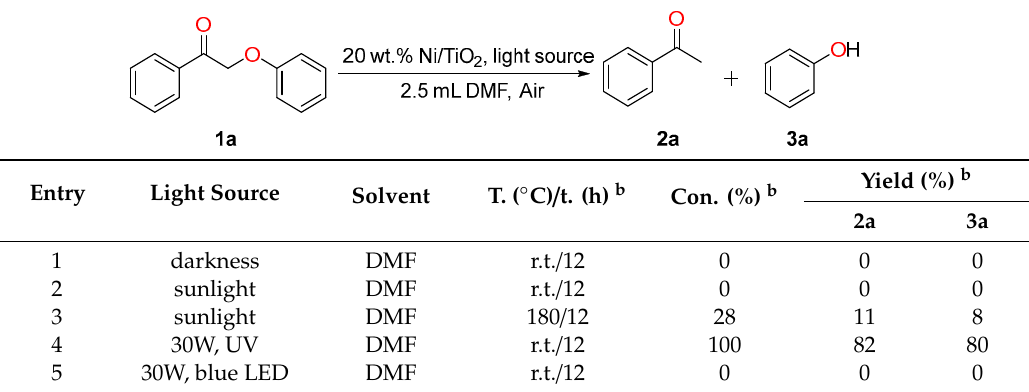
Table 2. Optimization of light sources for the photocatalytic reaction of 1a a .